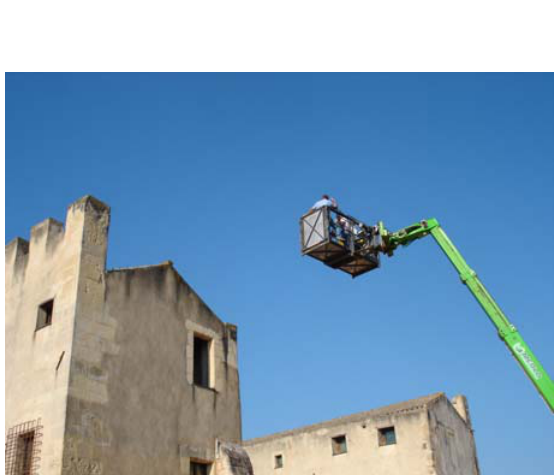
Fig. 8: Lifting platform to roof survey